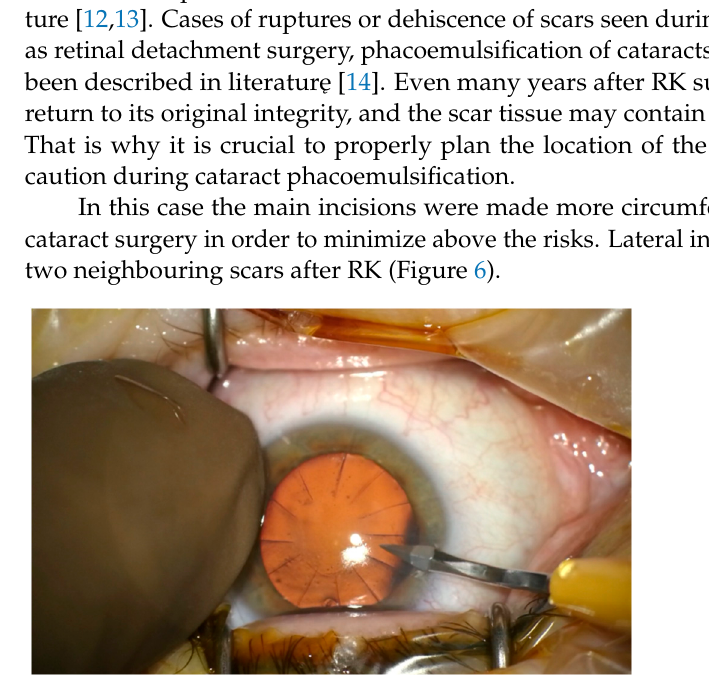
Figure 6. Location of lateral cuts between 2 neighboring incisions after radial keratotomy.